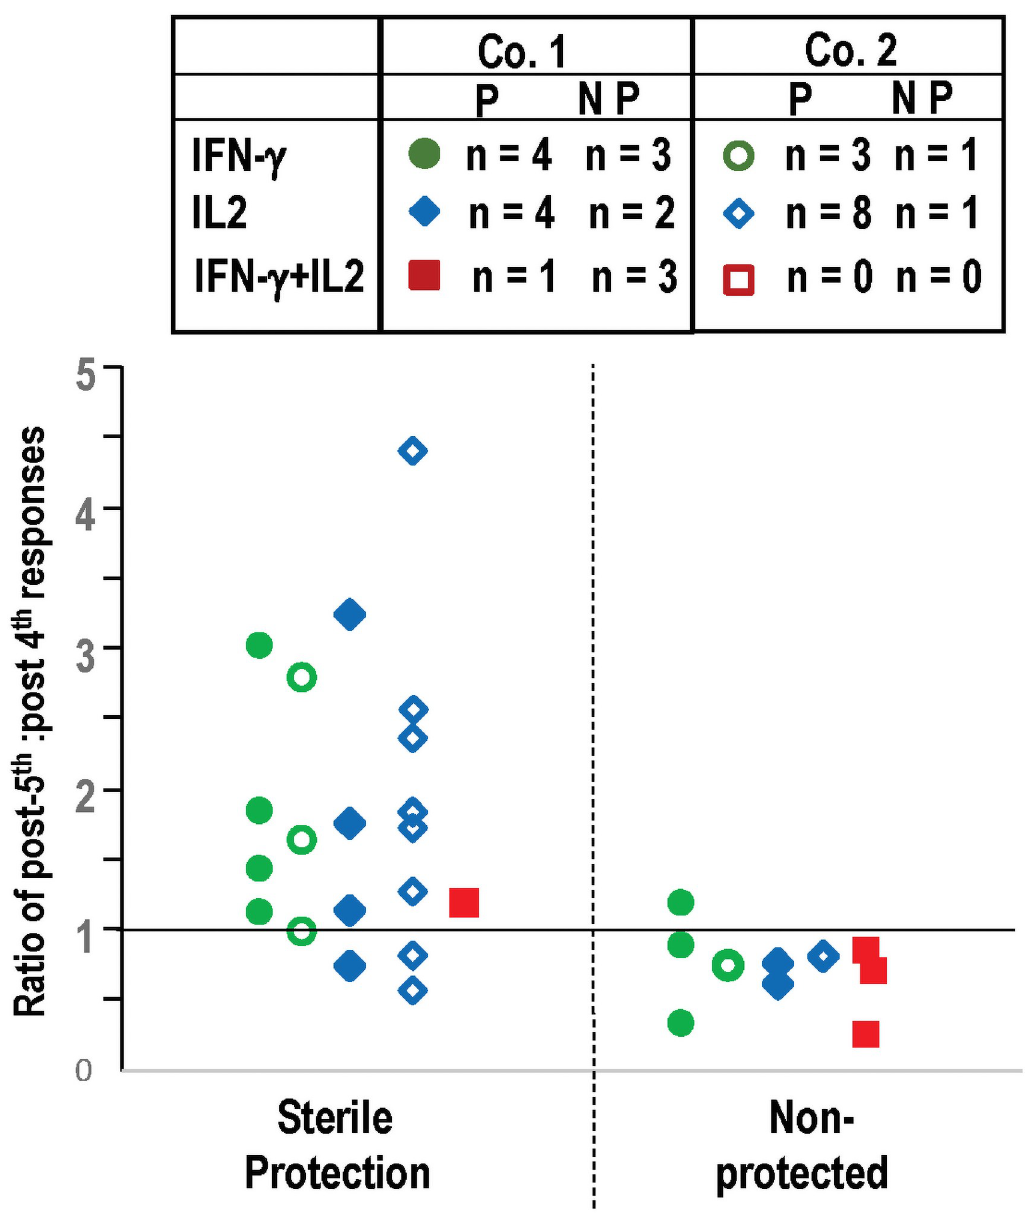
Fig 4. Comparison of the ratios post-5 th : Post-4 th IFN- γ , IL2 and IFN- γ +IL2 responses to SPZ of individual subjects Cohort 1 and Cohort 2. Only subjects with positive post-4 th and post-5 th IFN- γ , IL2 and IFN- γ +IL2 SPZ responses were included as shown in box. The ratios of post-5 th : post-4 th positive IFN- γ , IL2 and IFN- γ +IL2 responses were determined in protected and non-protected subjects. When responses were unchanged the ratio was 1.0 and that was chosen as an arbitrary cut off. IFN- γ (green) circles, IL2 (blue diamonds) and IFN- γ +IL2 (red squares); Cohort 1 (closed symbols) and Cohort 2 (open symbols). Protected subjects: IFN- γ : 7/7 (100%) were 1.0 or greater; IL2 : 9/12 (75%) were > 1.0, IFN- γ +IL2 : 1/1 (100%) were > 1.0. Non- protected subjects : IFN- γ : 3/4 (75%) were < 1.0, IL2 : 3/3 (100%) were > 1.0; IFN- γ +IL2 :3/3 (100%) were < 1.0. Therefore, only one non-protected subject in Cohort 1 had IFN- γ responses > 1.0.